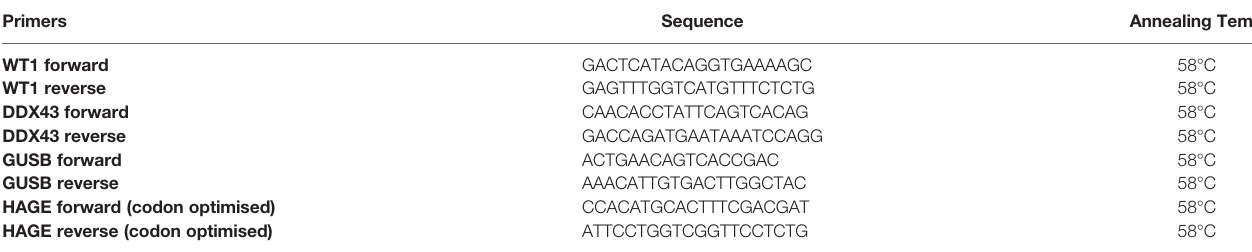
TABLE 1 | Primers and annealing temperatures used in RT-qPCR assay.